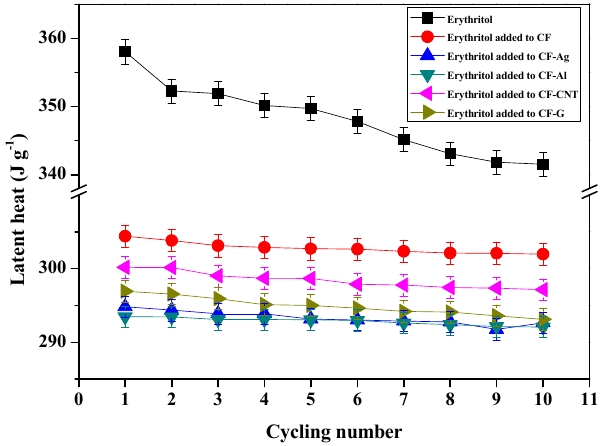
Figure 5. Thermal cycling test for pure erythritol and erythritol added to simple CF, CF-Ag, CF-Al, CF-CNT, and CF-G materials.